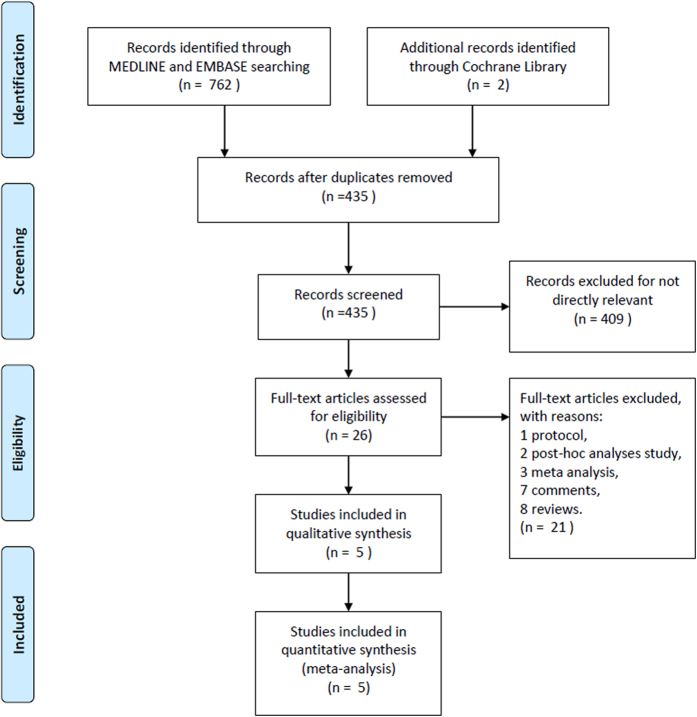
The study search, selection and inclusion process.